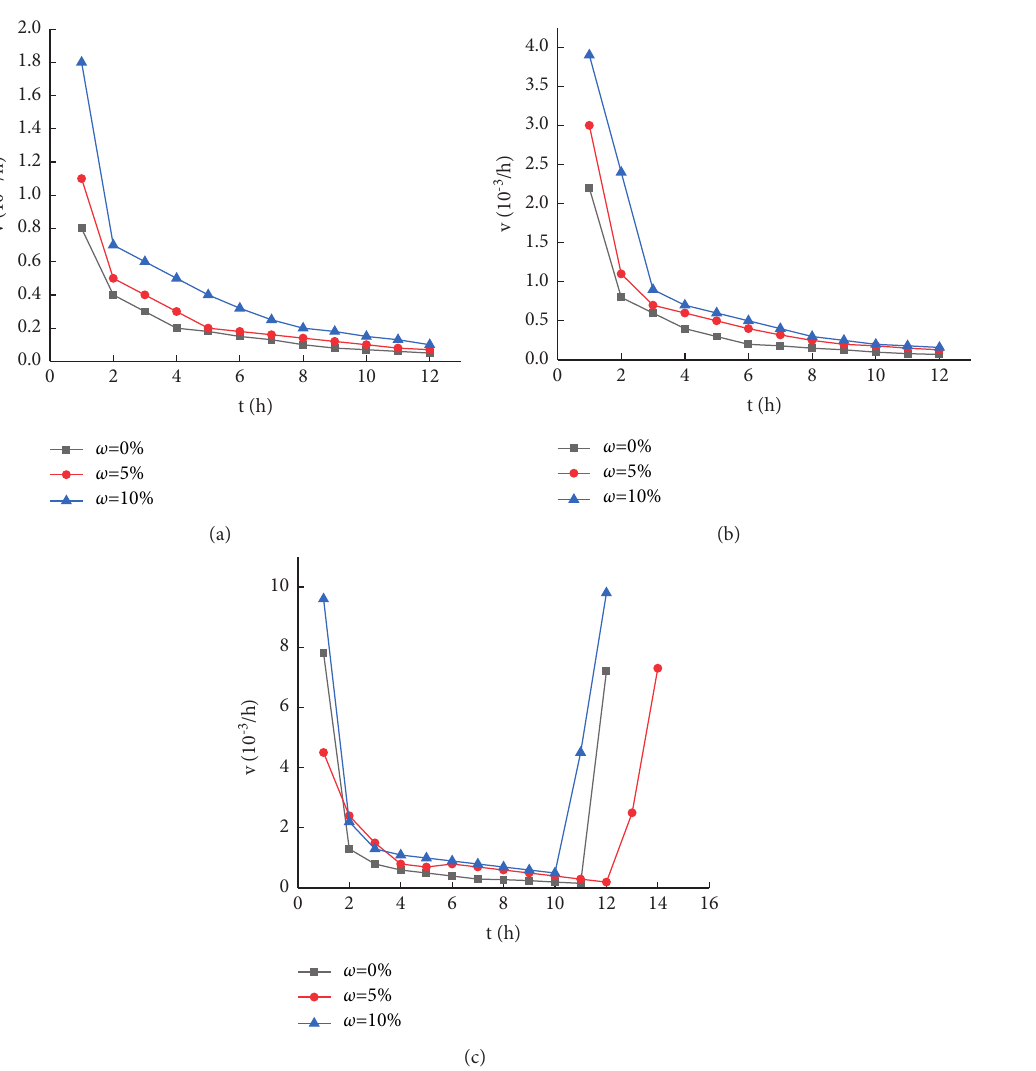
Figure 5: Creep velocity curves for the mudstone specimens with different moisture contents: (a) σ � 10MPa; (b) σ � 14MPa; (c) σ �